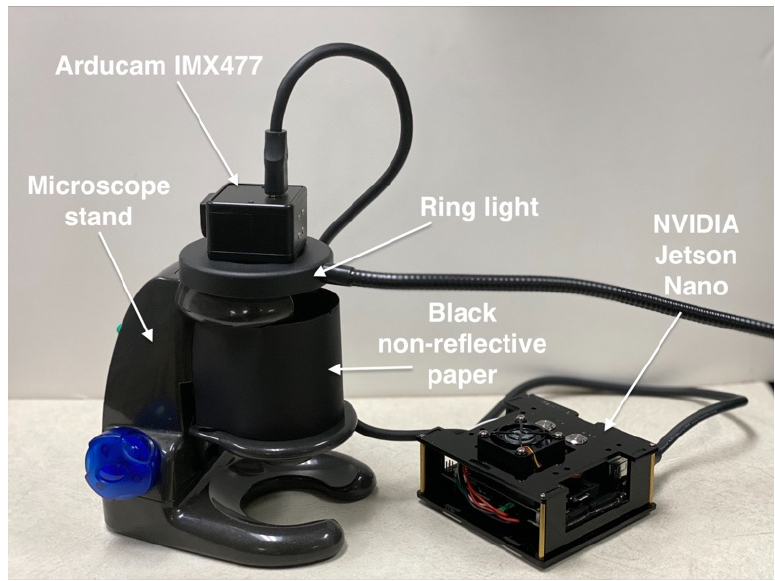
Figure 1. Connected hardware set-up.